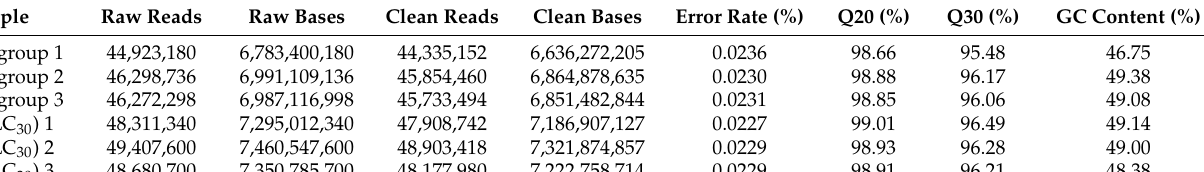
Table 1. Date control statistics of transcriptome of S. exigua.